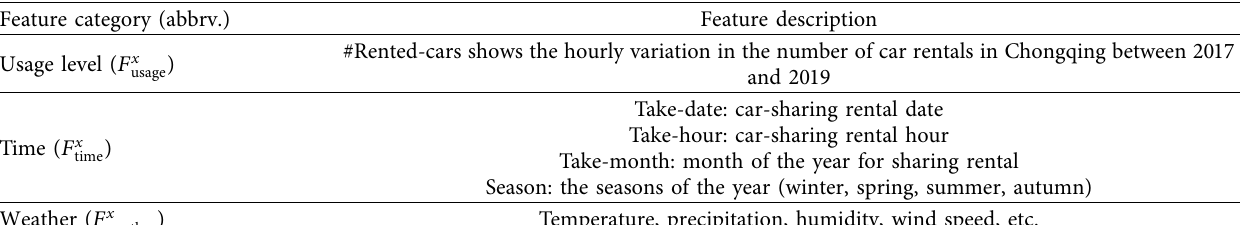
Table 1: Categories of features.